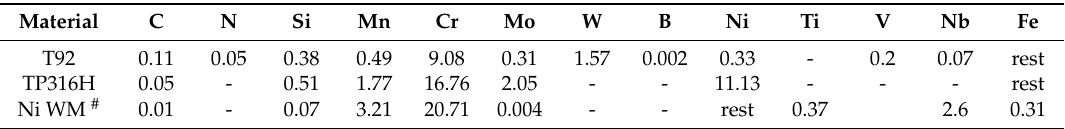
Table 1. Chemical composition (wt.%) of individual materials used for fabrication of T92/TP316H dissimilar weldments with Ni-based weld metal.